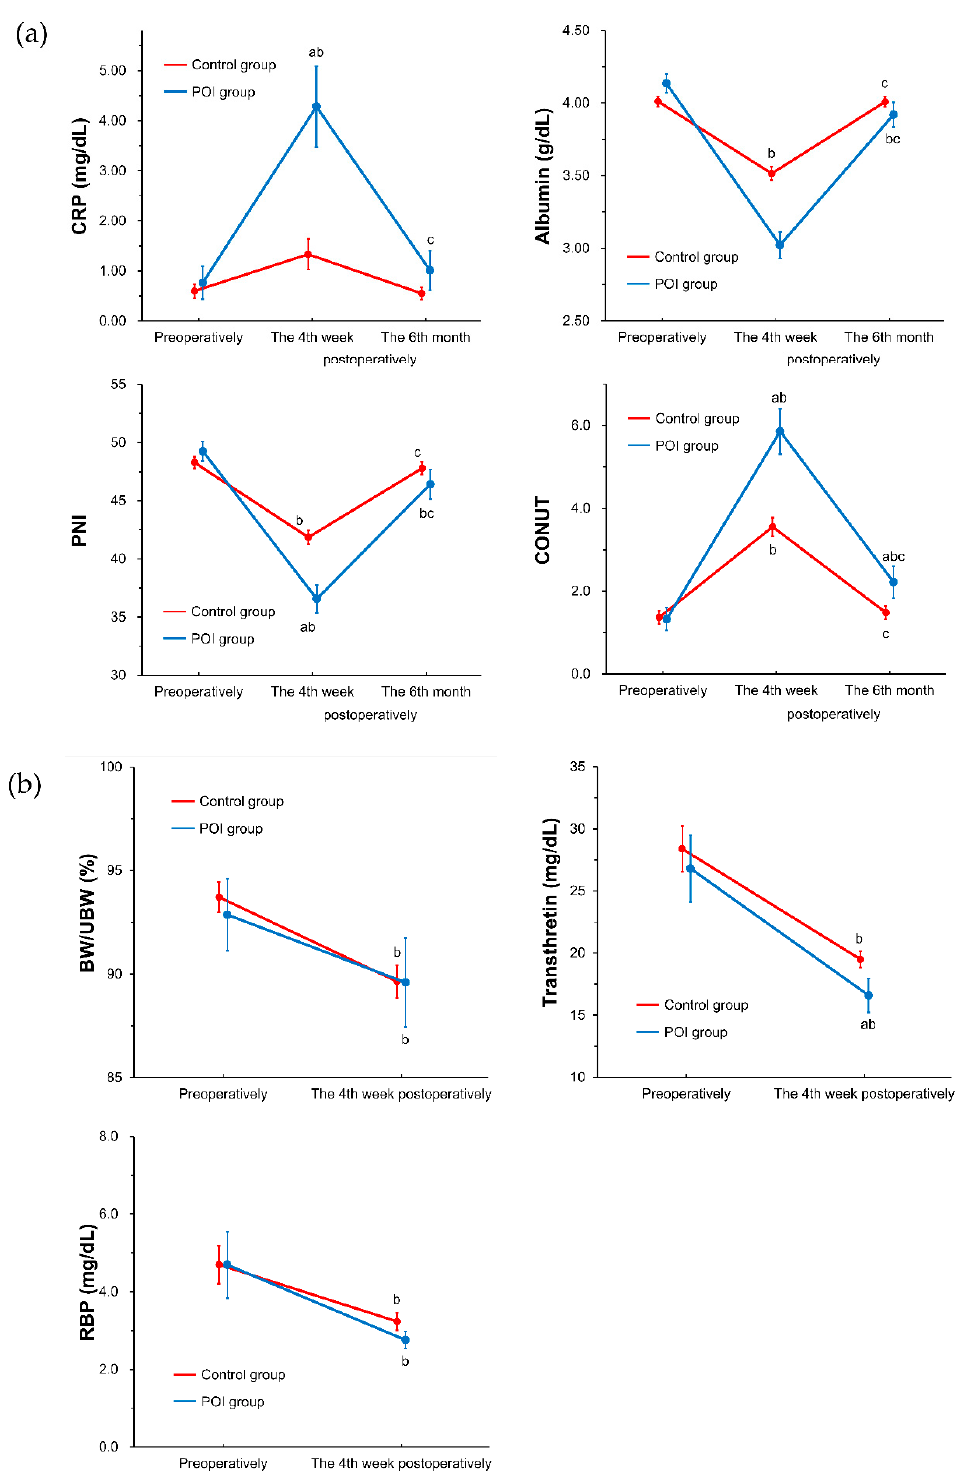
Figure 3. Changes of nutritional status during the follow-up period. ( a ) from preoperatively to the 6th month postoperatively, ( b ) from preoperatively to the 4th week postoperatively. Di ff erences between two study groups and two study time points were analyzed using split-plot analysis of variance and Bonferroni adjustment for multiple comparisons. Data are shown as mean ± standard error. a, p < 0.05 (vs. control); b, p < 0.05 (vs. preoperatively); c, p < 0.05 (vs. the fourth week postoperatively); BW / UBW, body weight at each study time points per usual body weight.